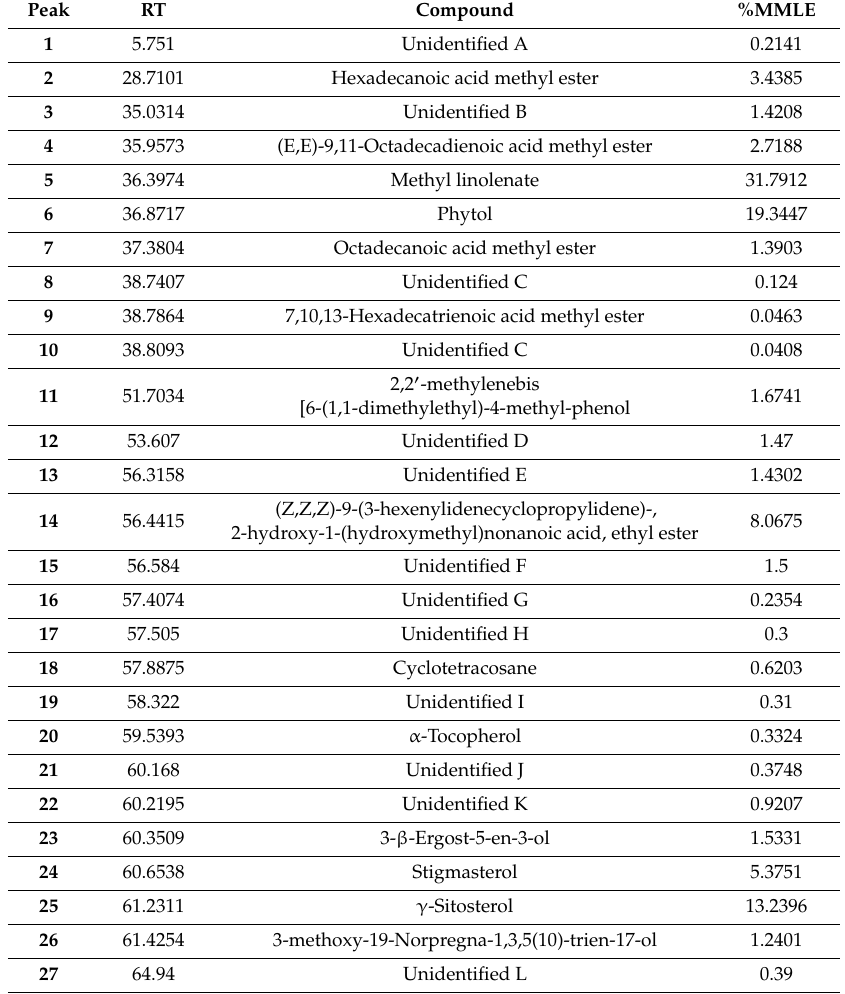
Figure 7. Chromatogram of M. pseudolavatera Webb & Berthel. methanolic leaf extract elucidated by GC-MS. Analysis of the different peaks obtained at different retention times with varying areas under the peak showed the presence of many compounds in different amounts. Table 1. Table showing the composition of the M. pseudolavatera Webb & Berthel. methanolic leaf extract as elucidated by GC-MS.